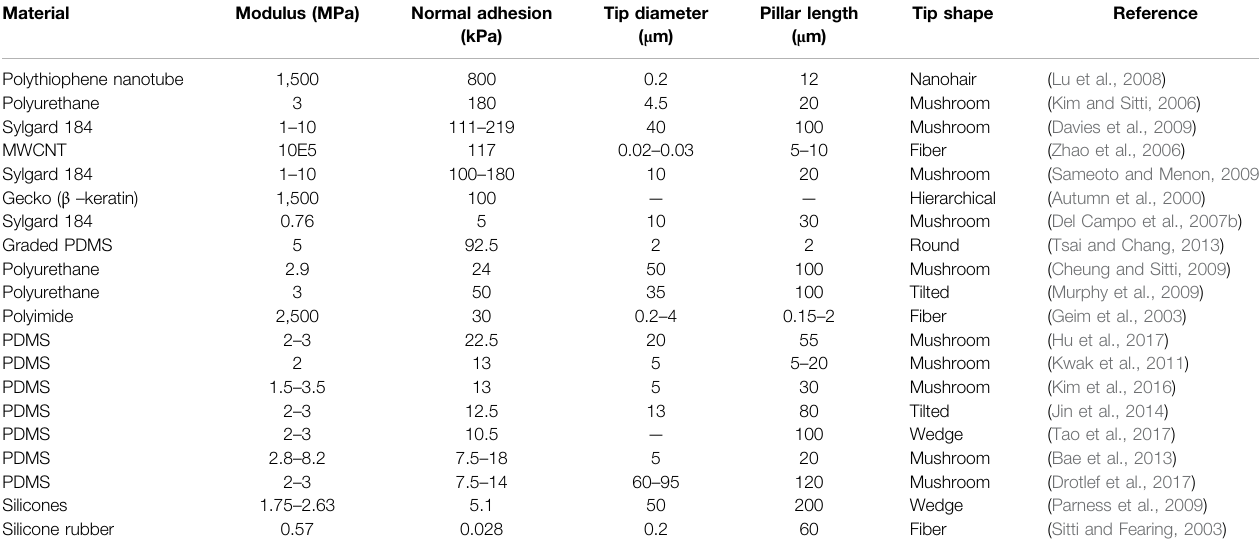
TABLE 1 | Micro-pillar-enabled Soft dry adhesives. Material